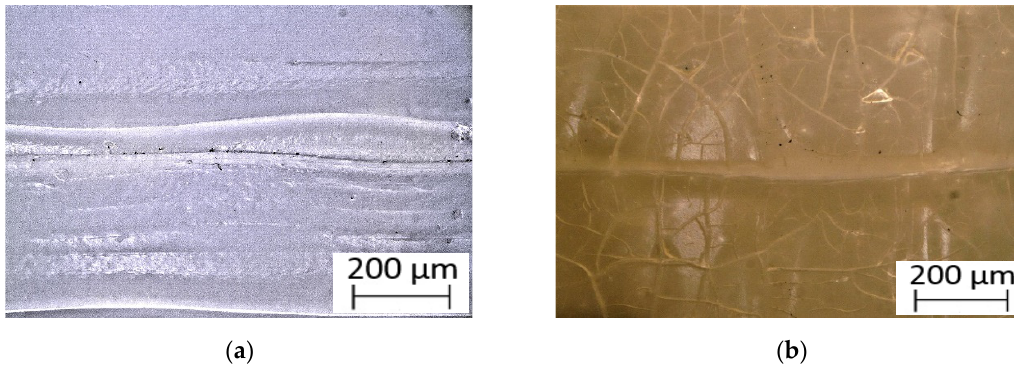
Figure 2. Digital microscopy images of the surface of uncoated acrylonitrile-butadiene-styrene (ABS) specimen ( a ) before and ( b ) after 1200 h of exposure to UV radiation and moisture.